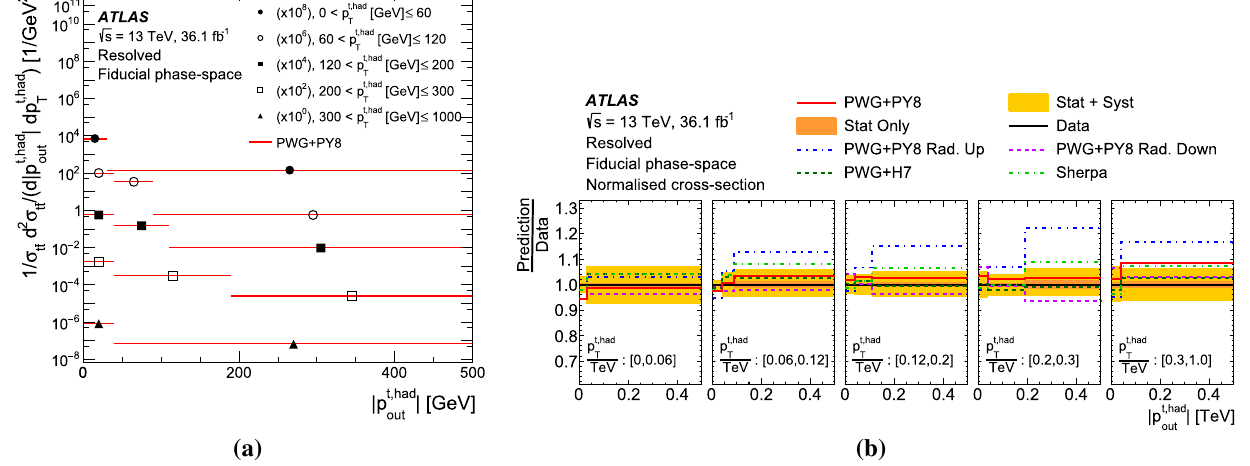
Fig. 28 a Particle-levelnormaliseddifferentialcross-sectionasafunc- tion of